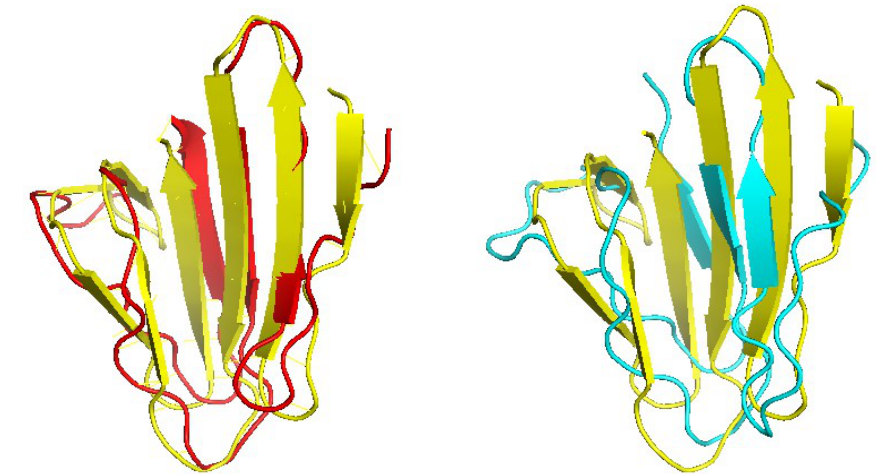
Figure 13. ( Left ) Structure model of d1gjwa1 (Thermotoga maritima maltosyltransferase) based on CRFalign alignment (red) of d1gjwa1-d1ktba1 overlapped with the experimental structure of d1gjwa1 (yellow) (with TM score = 0.6243, rmsd = 2.781 ) and ( right ) that based on the base model alignment (cyan) overlapped with the experimental structure (yellow) (with TM score = 0.4907, rmsd = 4.616